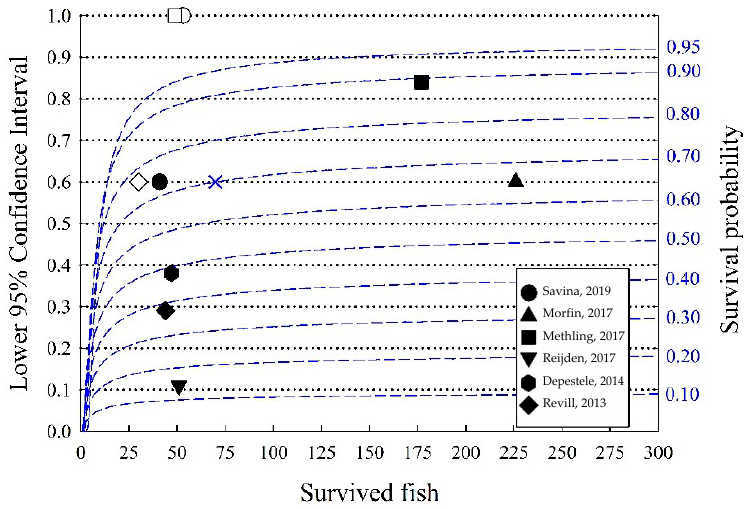
Figure 1. The plot shows the lower 95% confidence limit (left axis and dotted lines) for estimated survival probabilities (right axis with blue numbers and blue dashed lines) using the Kaplan–Meier model as a function of the surviving fish. Black symbols represent the studies presented in Table 1, and white symbols represent control groups (when available). The blue cross was used as an example in the test.